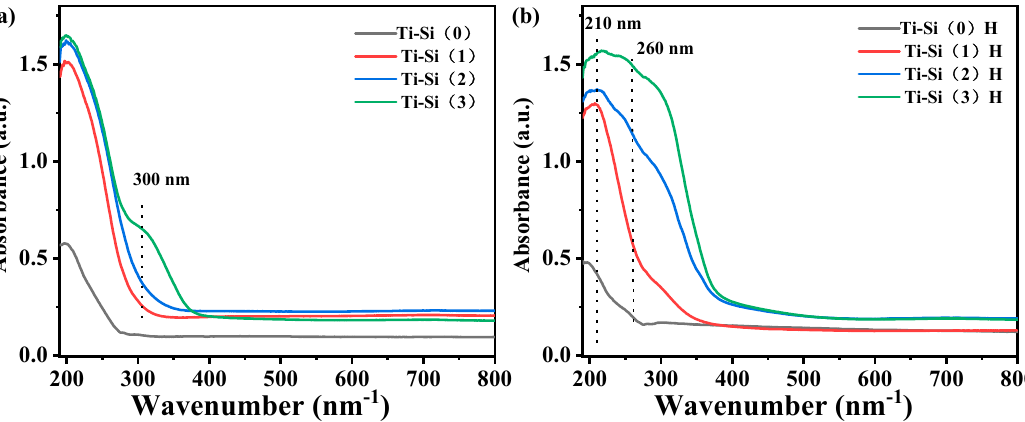
Figure 3. UV-Vis spectra of mesoporous silica catalysts with different Ti contents: ( a ) before hydrothermal treatment, ( b ) after hydrothermal treatment.